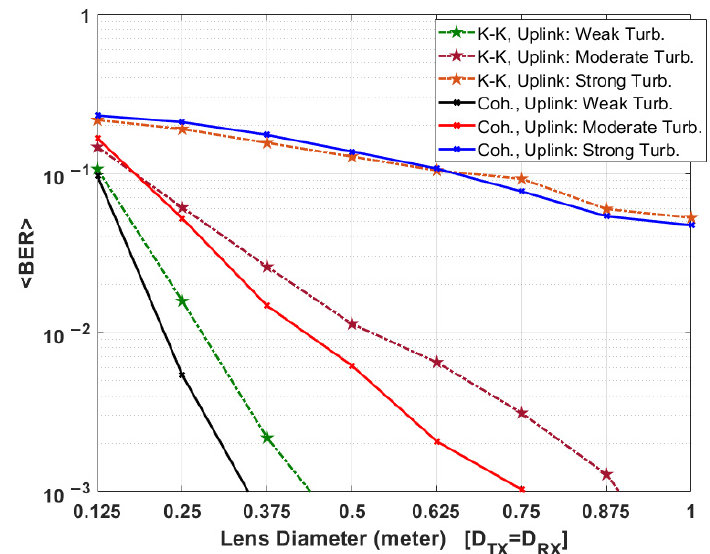
Figure 10. Comparison between KK and coherent transceiver uplink performance in the presence of scintillation versus telescopes lens diameter (Tx/Rx amplifier gains are 30 dB, Tx/Rx Lens diam- eters are assumed equal. Also, please see C 2 n ( 0 ) values in Table 1 for weak, moderate, and strong turbulence).